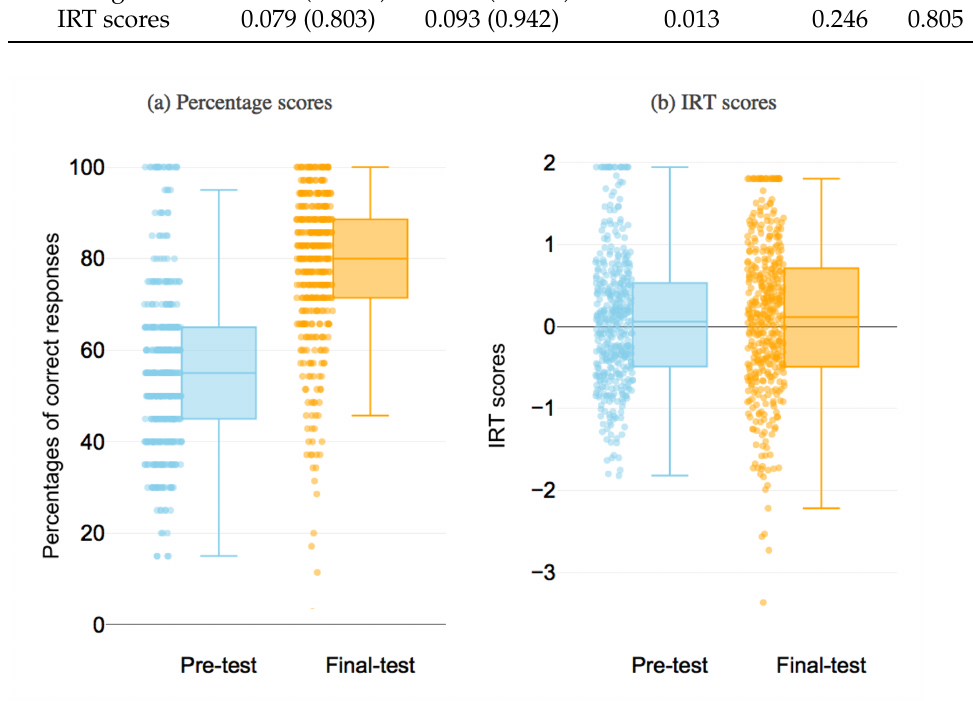
Figure 6. Learning gains between the pre- and